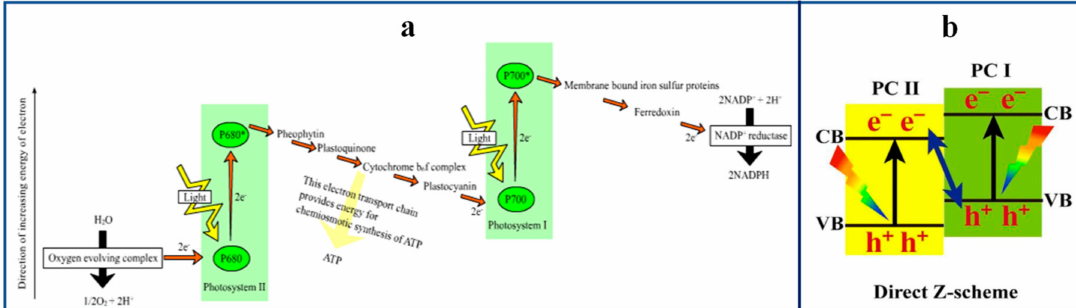
Figure 21. Panel ( a ) The mechanism of natural photosynthesis, in which P680 indicates the pigment (chlorophyll) that can absorb 680 nm light in photosystem II (PS II), and P680* is the excited state of P680. P700 indicates the pigment (chlorophyll) that can absorb 700 nm light in photosystem I (PS I), while P700* is the excited state of P700 (Z-scheme. Available online: http: // commons.wikimedia.org / wiki / File: Z-scheme.png, accessed on 9 January 2020). Panel ( b ) Schematic illustration of direct Z-scheme heterojunction, inwhichCB,VB,PCI,andPCIIindicatetheconductionband, valenceband, photocatalyst I, and photocatalyst II, respectively. Reprinted with permission [325]. Copyright Elsevier